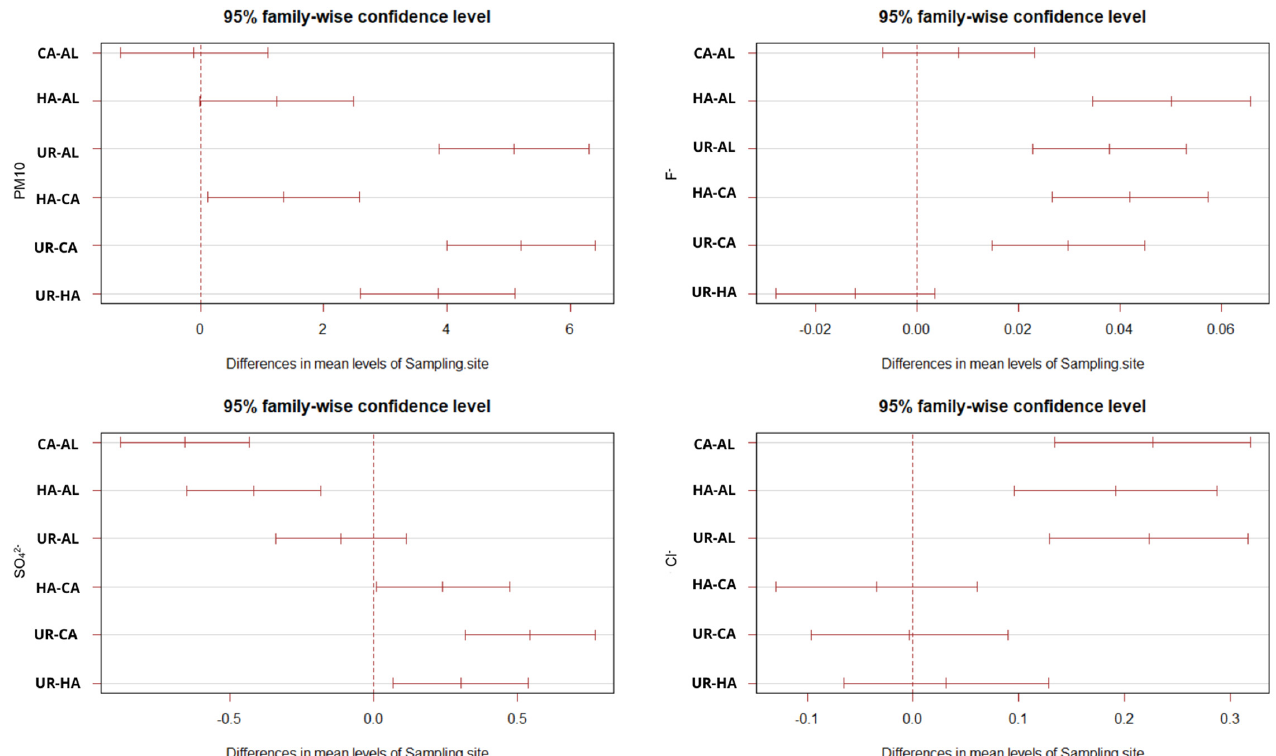
Figure 2. Mean Tukey test results for the sampling sites, 2011 − 2018 . The ions analyzed contribute to 33%, 34%, 35%, and 37% of the PM 10 collected for sampling